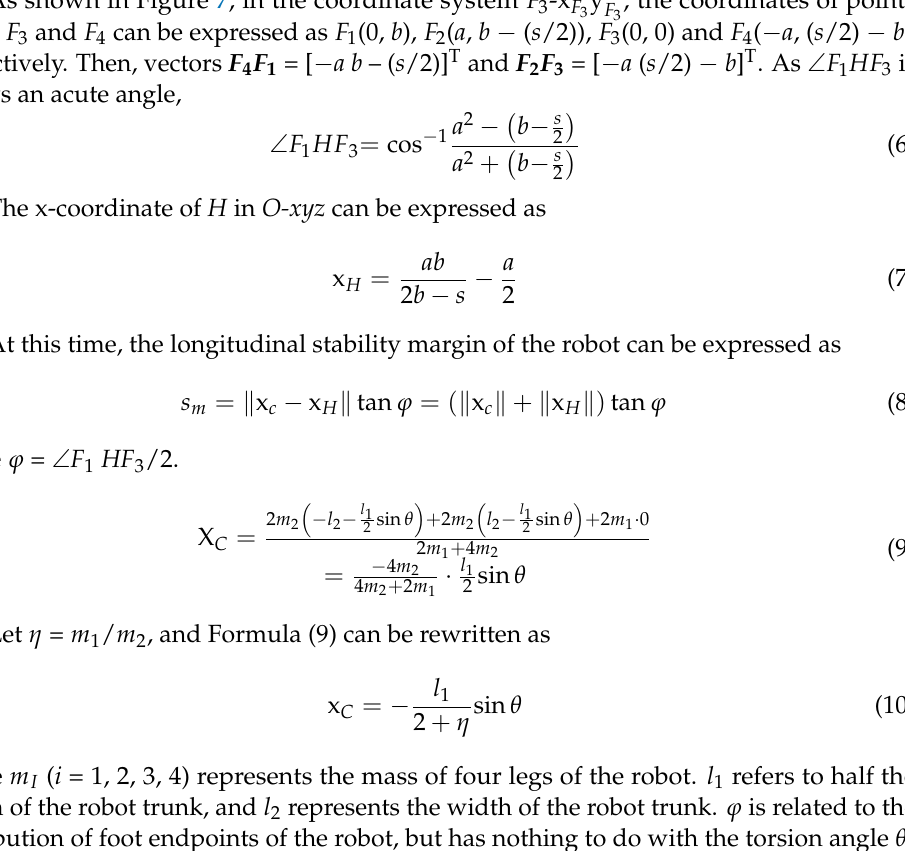
Figure 7. Influence of the flexible waist on LSM.